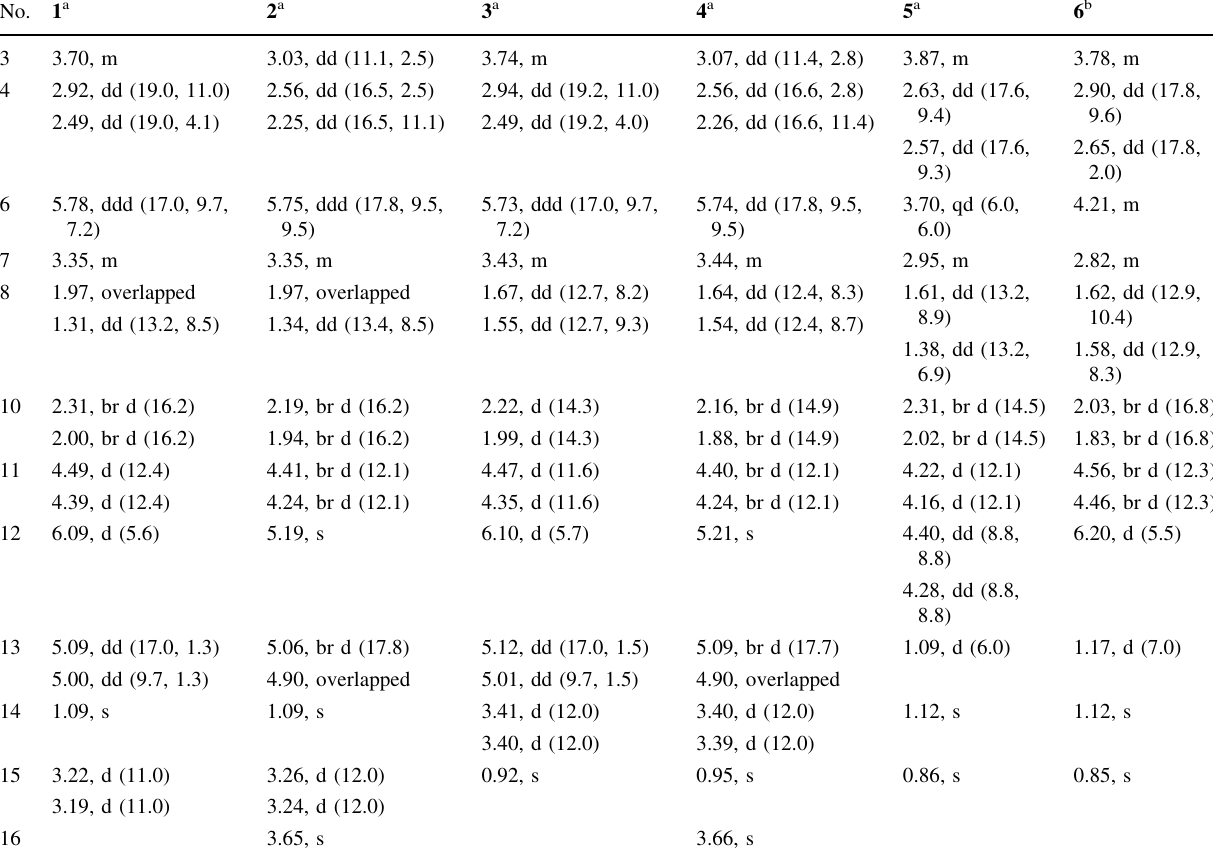
Table 1 1 H NMR spectroscopic data of compounds 1 – 6 ( d in